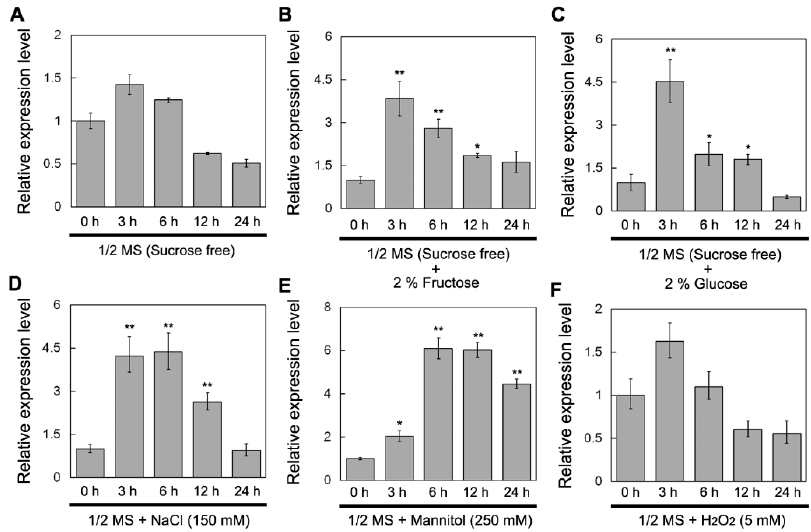
Figure 2. Expression analysis of DsSWEET17 under different sugar and other stress treatments. One-week-old D. spiculifolius seedlings were treated with 1/2 Murashige and Skoog’s (MS) medium supplemented with sucrose (free) ( A ); fructose (2%) ( B ); or glucose (2%) ( C ); and 1/2 MS medium (3% sucrose) supplemented with NaCl (150 mM) ( D ); mannitol (300 mM) ( E ); and H 2 O 2 (5 mM) ( F ) for 0, 3, 6, 12, and 24 h. DsActin was used as an internal control, and the transcript level in the untreated seedlings was set as 1.0. Asterisks indicate significant differences between untreated and stress-treated seedlings (* p < 0.05; ** p < 0.01; Student’s t test). Error bars show the SD of the values from three replicates.